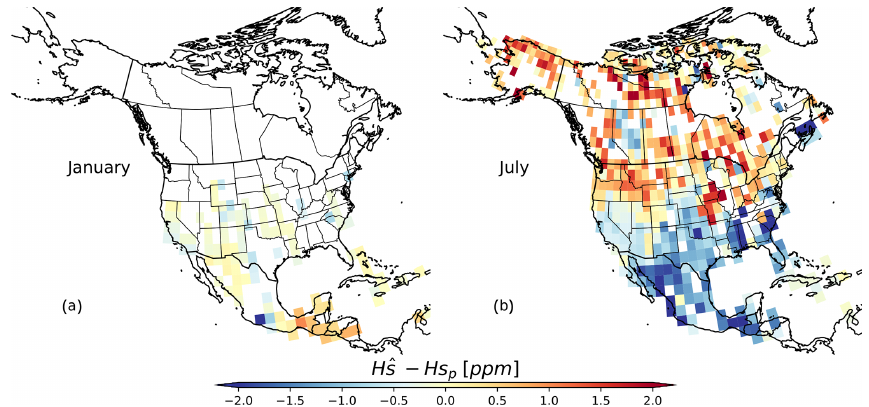
Figure 7. Difference between prior and optimized biospheric flux from CarbonTracker–Lagrange shows small differences when projected onto the total column